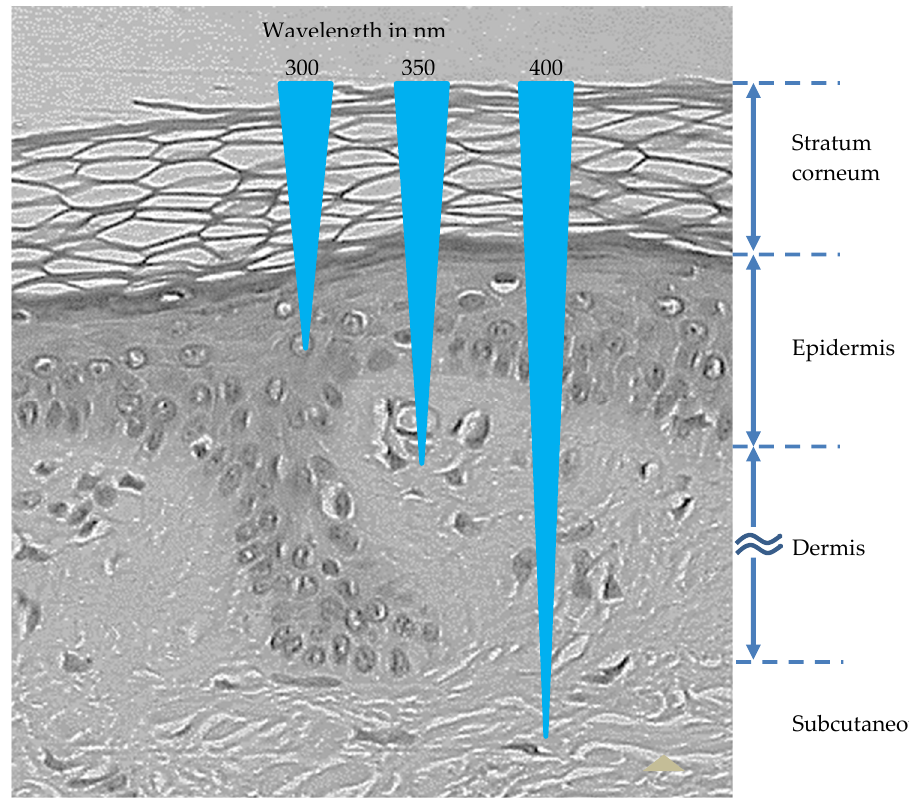
Figure 1. Skin penetration depth of different wavelenghts.